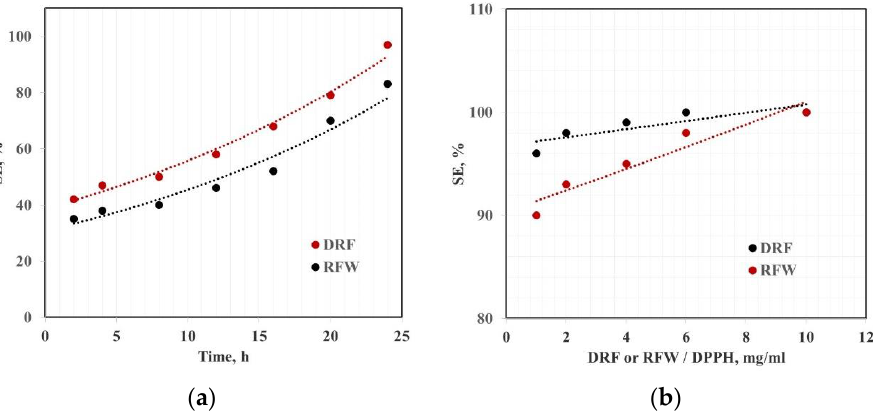
Figure 2. Scavenging efficiency of dry rose flower (DRF) and rose flower waste (RFW) of ( a ) 1 mg/mL of solid as a function of time (left) and ( b ) varying the content of solid in DPPH solution after 24 h (right).